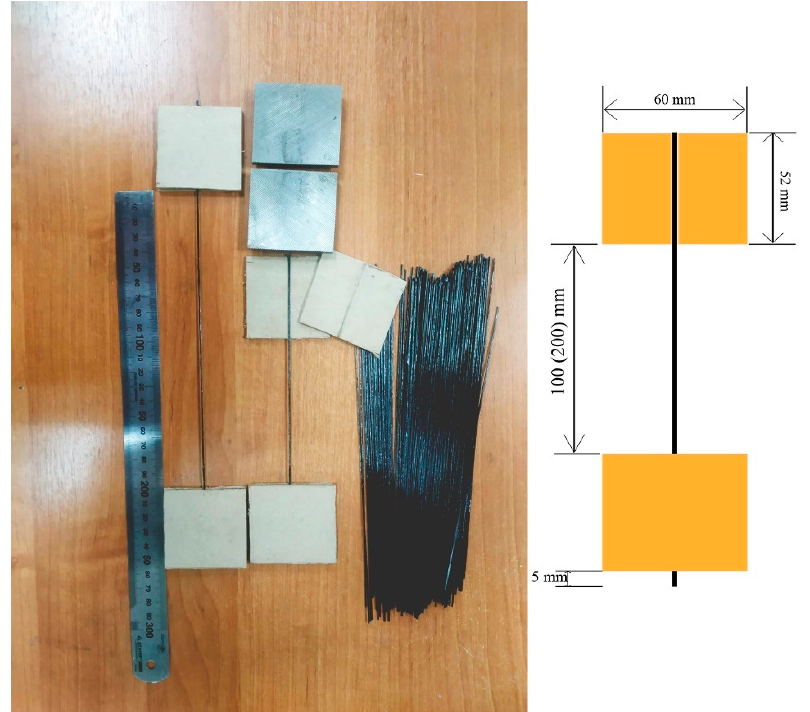
Figure 2. Samples and equipment for testing carbon